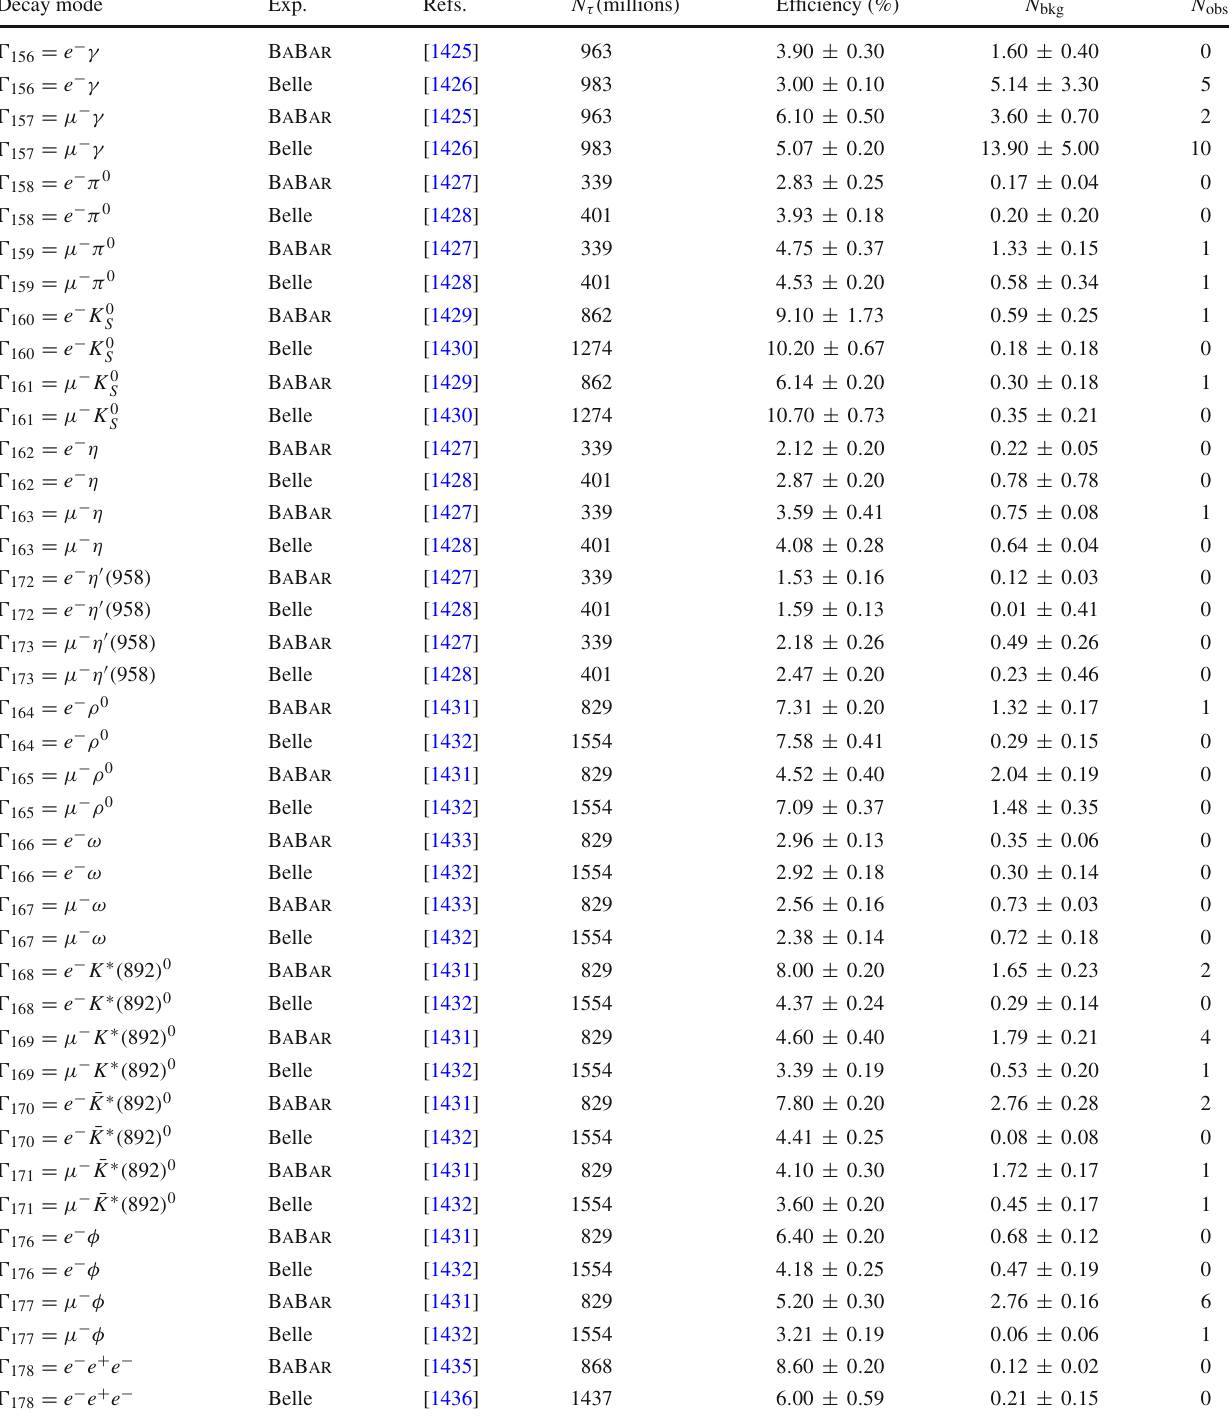
Table 319 Published information that has been used to re-compute upper limits with the CL s method, i.e. the number of τ leptons pro- duced, the signal detection efficiency and its uncertainty, the number of expected background events and its uncertainty, and the number of observed events. The uncertainty on the efficiency includes the minor